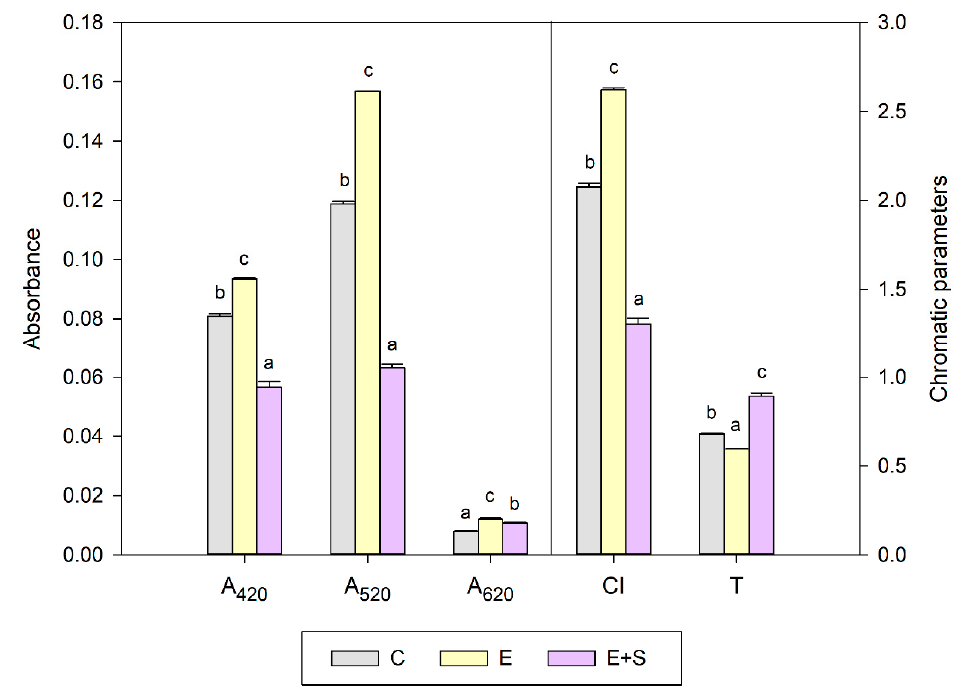
Figure 3. Chromatic parameters determined in Bobal grapes on harvest day. C: control grapevines (untreated); E: grapevines treated by endotherapy; E + S: grapevines treated by endotherapy and spraying. Left y -axis: A 420 (absorbance at 420 nm); A 520 (absorbance at 520 nm); A 620 (absorbance at 620 nm). Right y -axis: CI (colour intensity); T (tonality). All data are expressed as mean ± SD ( n = 4). For each parameter, different letters indicate significant differences according to the Tukey test ( p < 0.05).